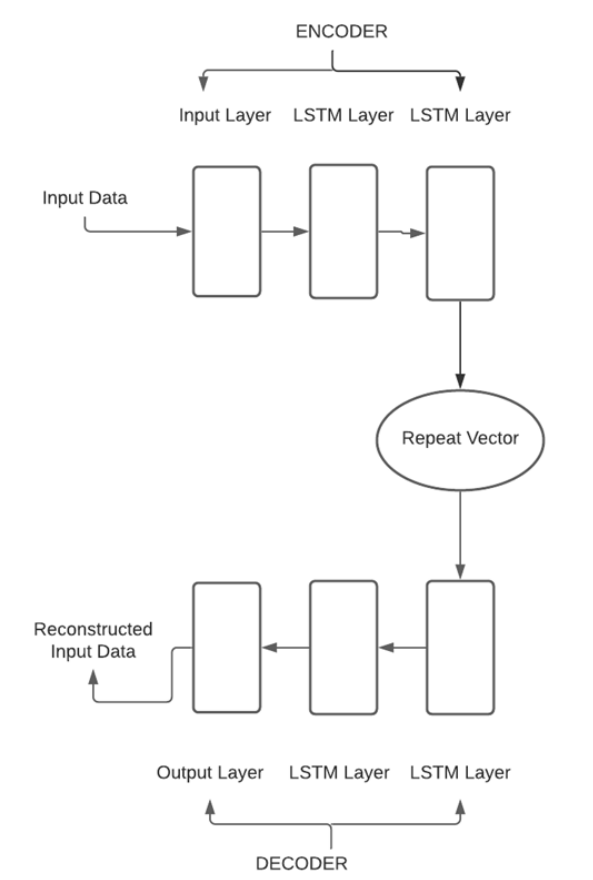
Figure 1. Schematic representation of the long-short term memory (LSTMAE)